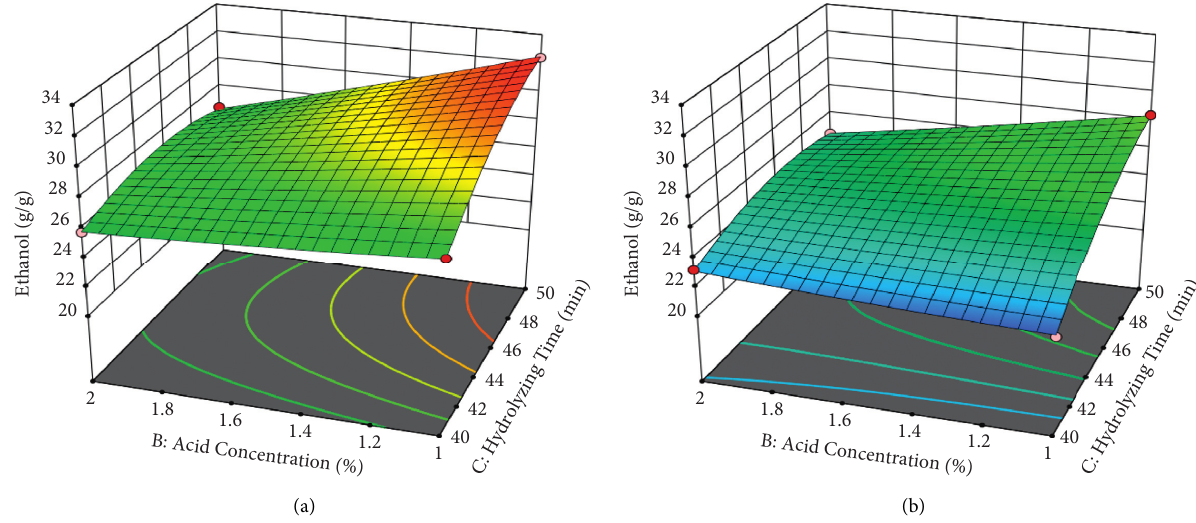
Figure 4: (a) The 3D response surface plot for the ethanol yield at a higher level of temperature (116 ° C). (b) The 3D response surface plot for the ethanol yield at a lower level of temperature (104 °